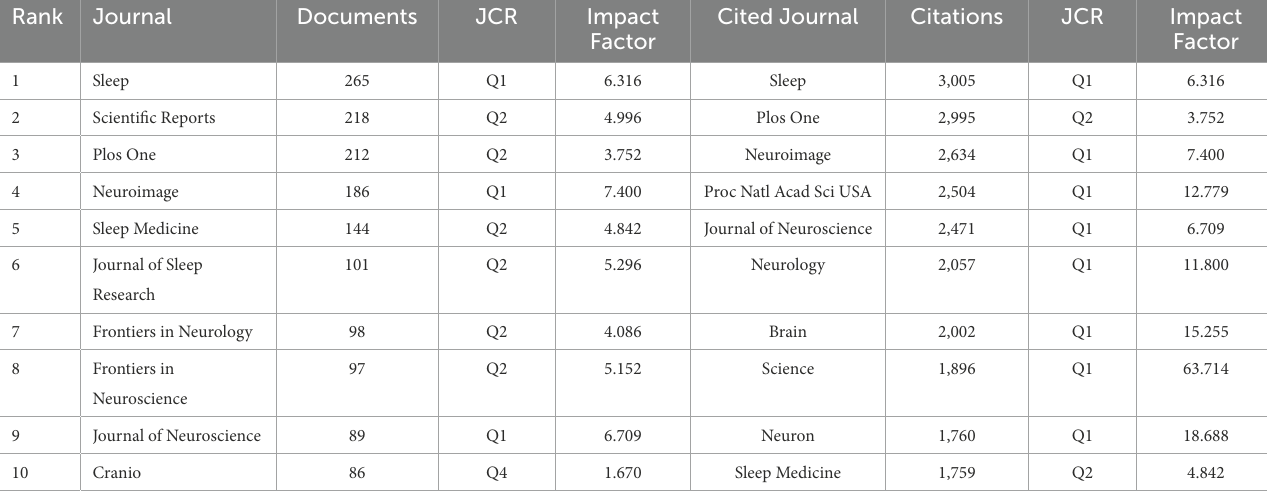
TABLE 3 Top 10 journals in terms of number of articles and citations. Rank